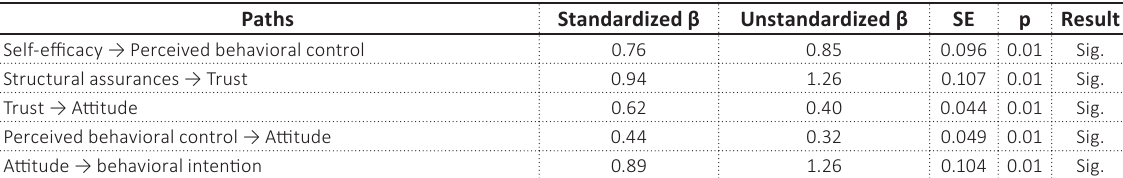
Table 5. Path analysis